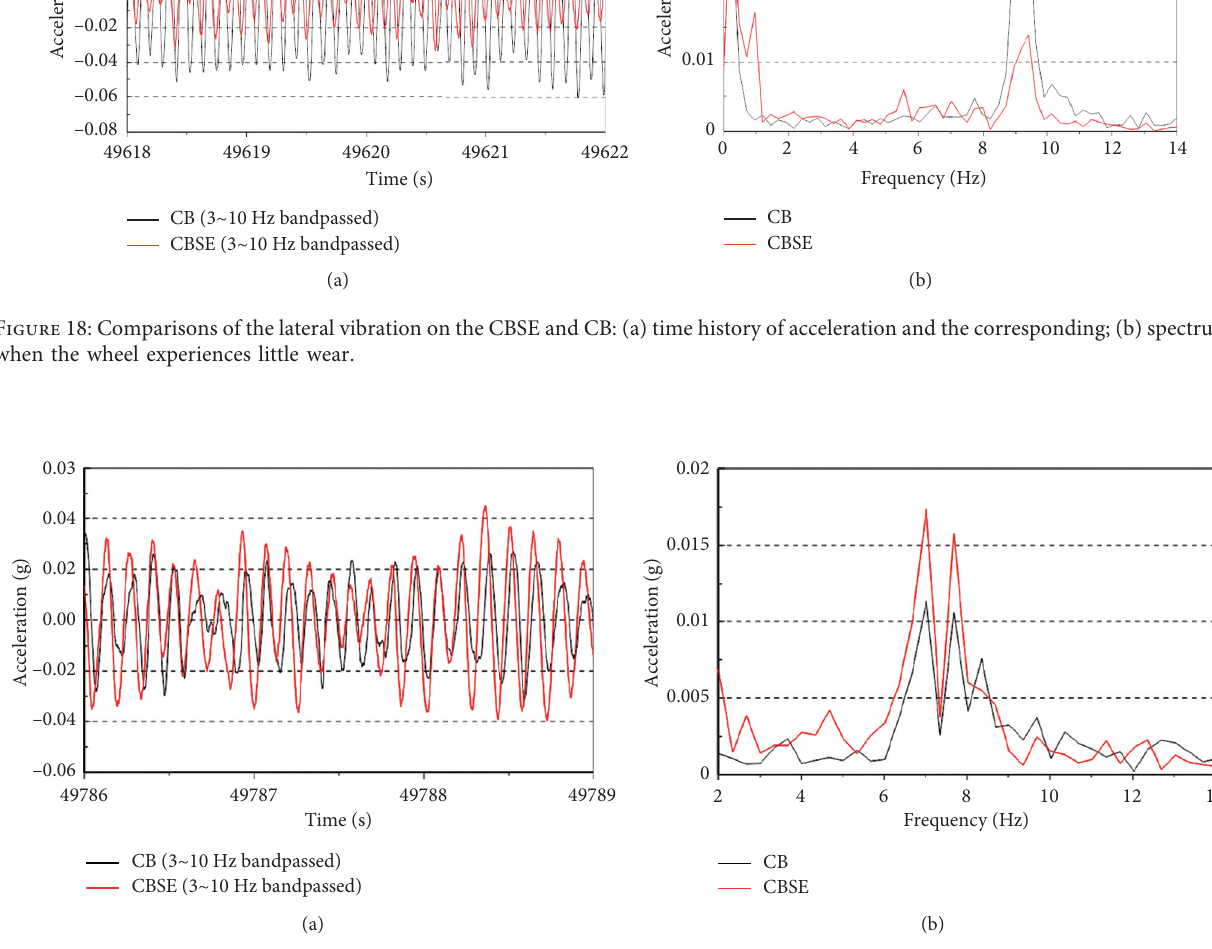
Figure 19: Comparisons of the lateral vibration on the CBSE and CB: (a) time history of acceleration and the corresponding; (b) spectrums when the wheel experiences severe